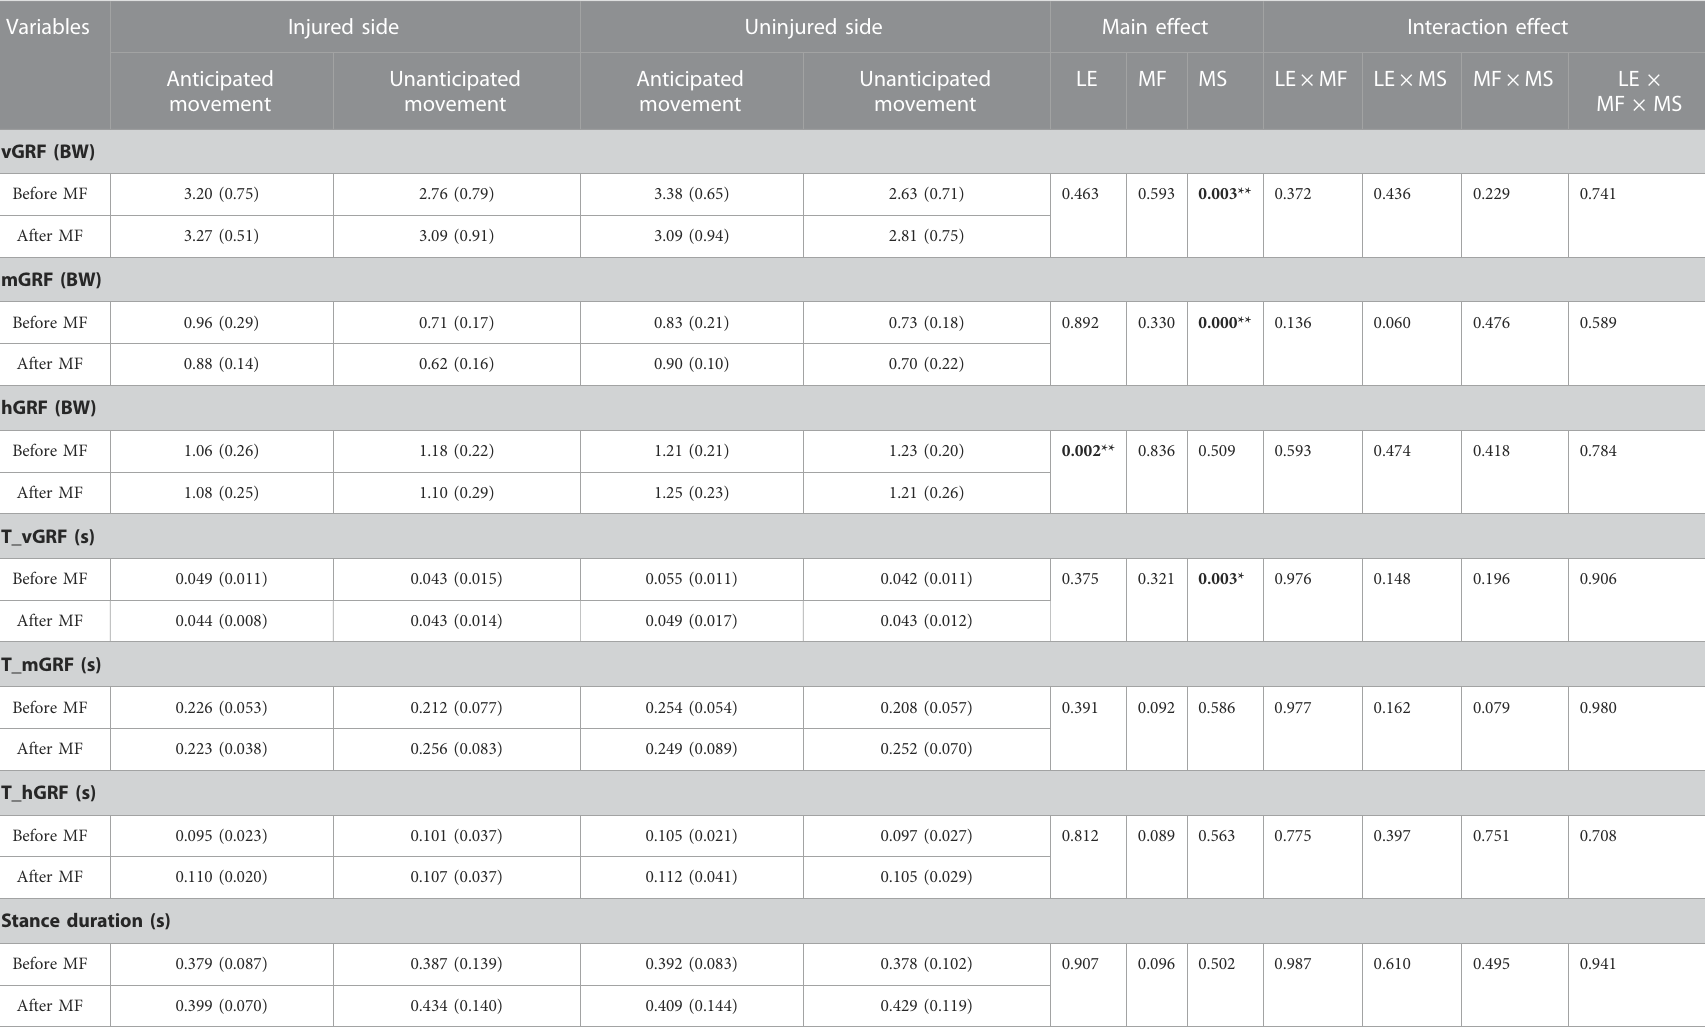
TABLE 2 Peak ground reaction force, time to peak ground reaction force, and stance duration during side-step